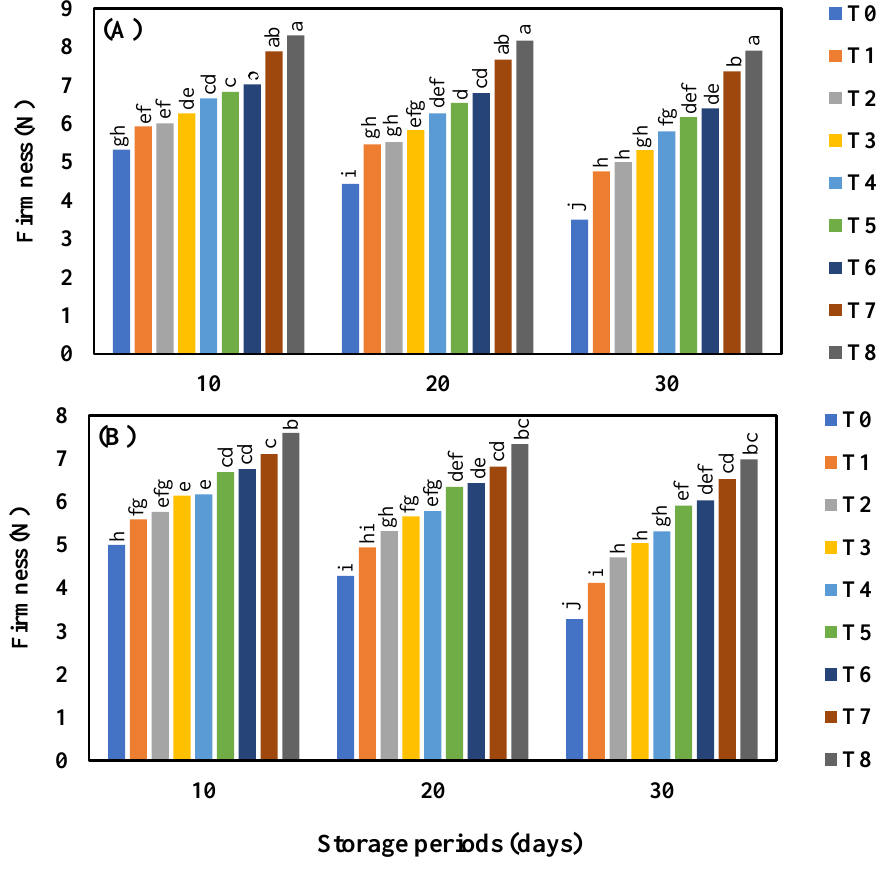
Figure 2. Effect of AgNO 3 and Ag-NPs on Firmness Force (N) in Shine Muscat ( A ) and Kyoho ( B ) grape varieties during 30 days cold storage.